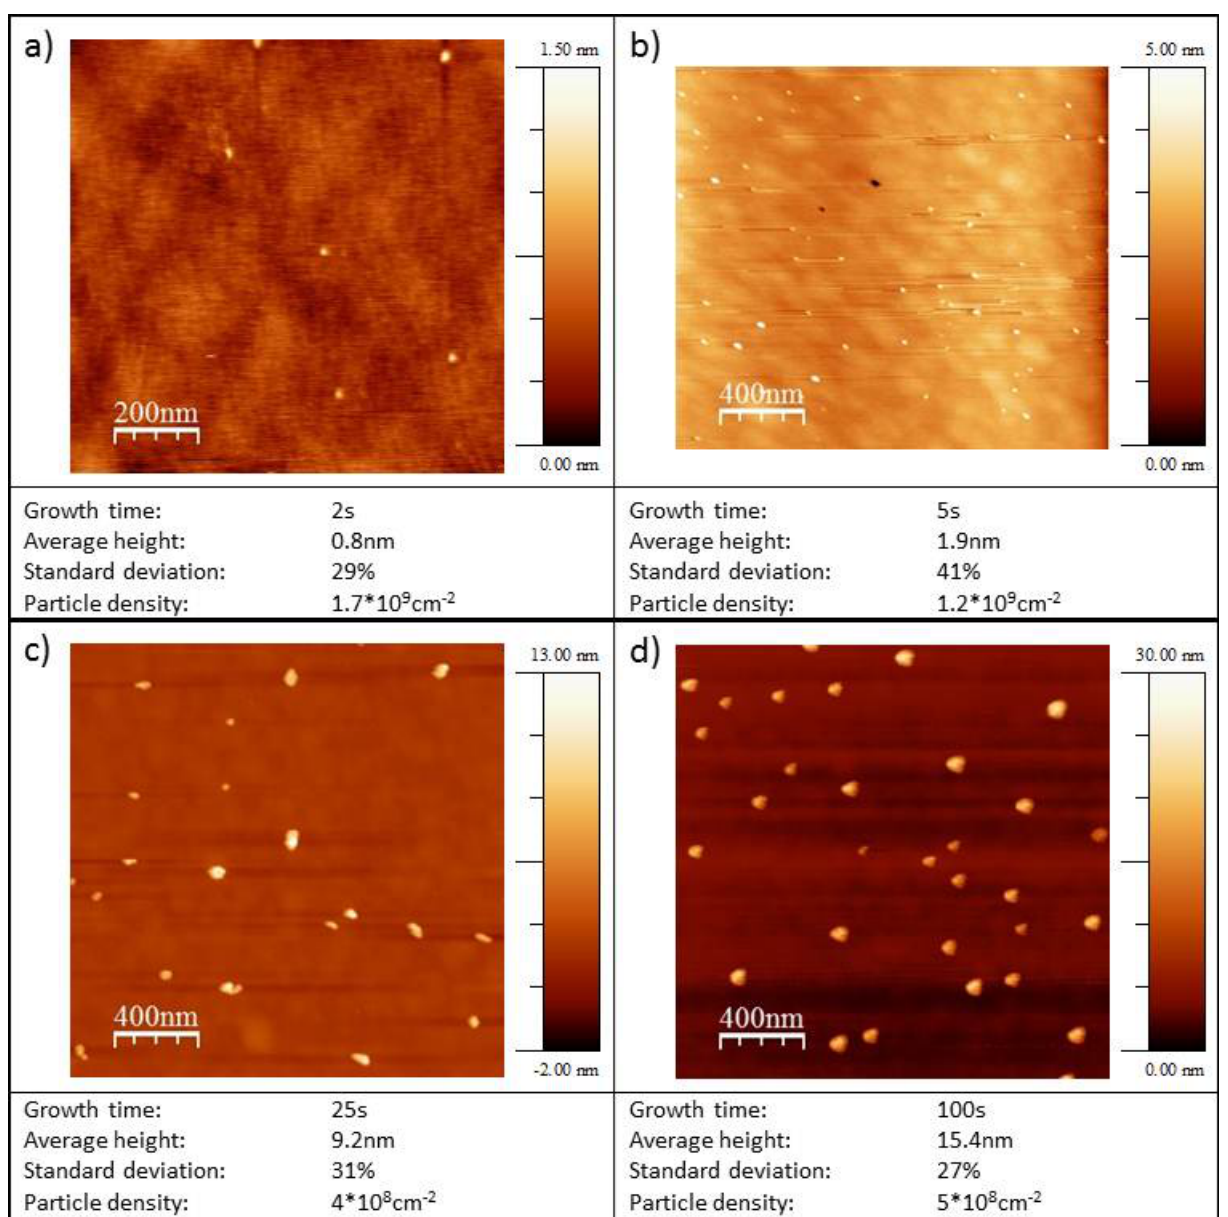
Figure 3. TM-AFM micrographs of Au nanoparticles on diamond. The deposition parameters were: Nucleation pulse: 10 ms, − 140 mV vs. NHE, growth pulse: Variable duration as given in micrograph captions, 895 mV vs.